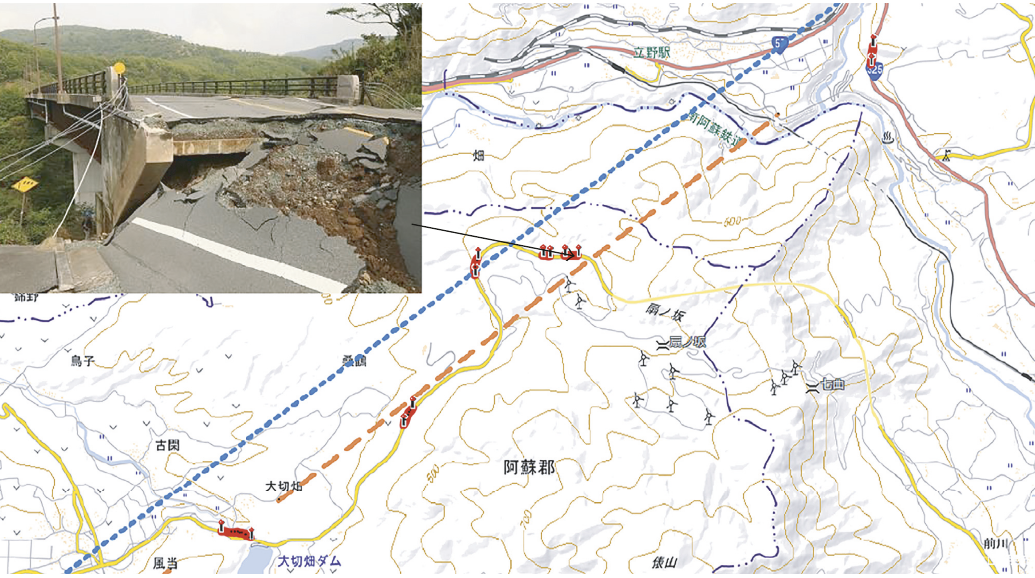
Figure 7: Location of Tawarayama